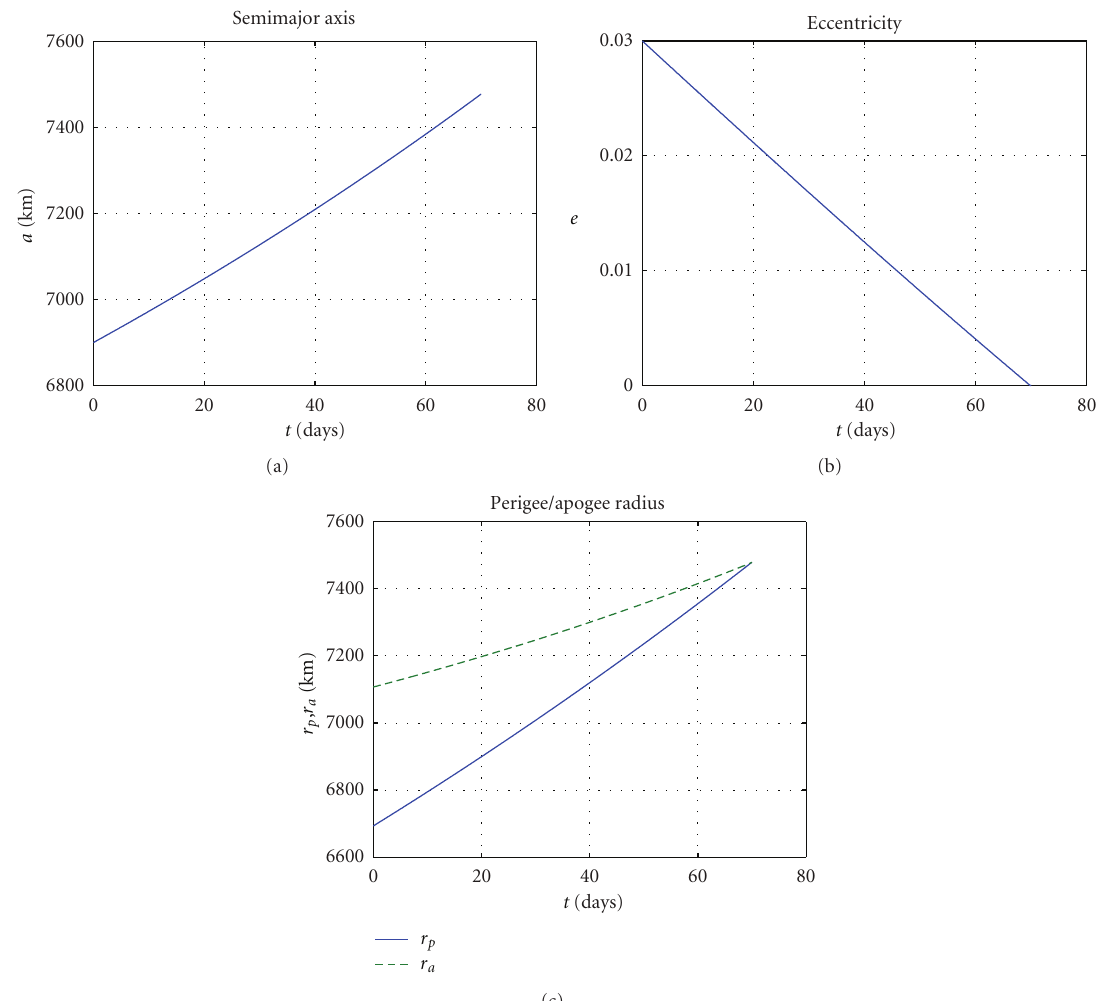
Figure 7: (a) Variation of semi-major axis, (b) eccentricity, (c) perigee, and apogee radiuses for multi-revolution orbital transfer (coplanar case). Table 3: Mass, initial orbit parameters, and minimum de-orbit time of the debris. Debris